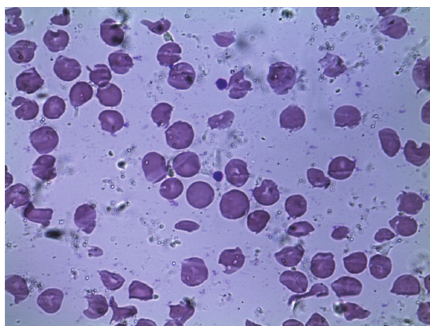
Figure 3: Peripheral smear showing polychromasia, helmet cells, fragmented RBCs, and anisopoikilocytosis.